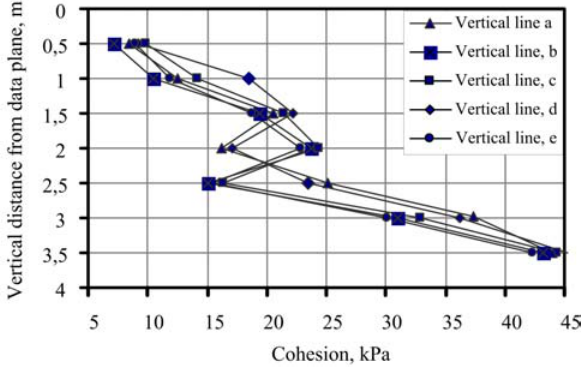
Fig. 7. Graph of c h − relationship according to field